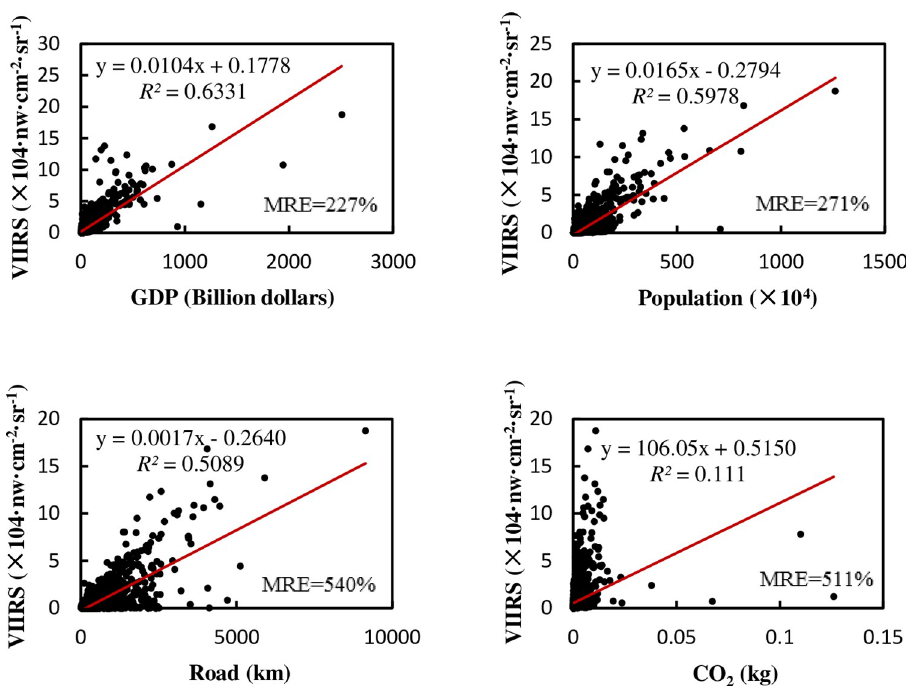
Fig 9. Relationship between total NTL and total elements in county-level administrative regions of China.